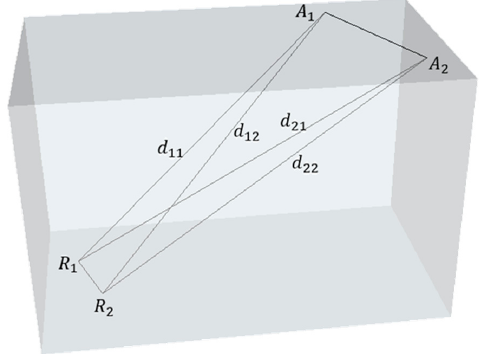
Figure 2. AP Deployment—Case Two.